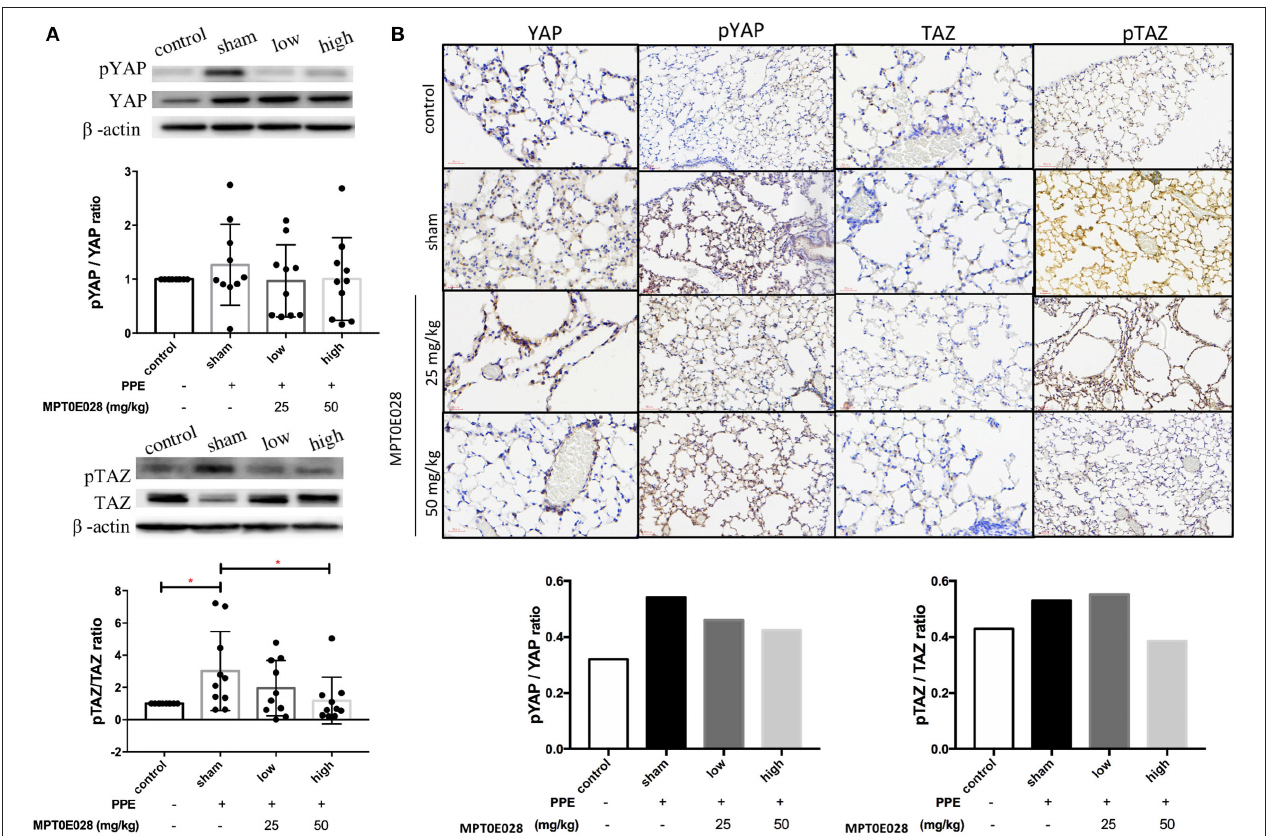
FIGURE 4 | Expressions of phosphorylated (p)-yes-associated protein (YAP) and p-transcriptional coactivator with a PDZ-binding motif (TAZ) in the lungs and alveolar regions by the MPT0E028 in mice with porcine pancreatic elastase (PPE)-induced emphysema. (A) Expressions of p-YAP/YAP and p-TAZ/TAZ in whole lung lysates by the MPT0E028 at 0, 25, and 50 mg/kg body weight (BW) ( n = 10). (B) Expressions of p-YAP/YAP and p-TAZ/TAZ in alveolar regions by IHC by the MPT0E028 at 0, 25, and 50 mg/kg BW ( n = 1) (magnification X20). * p < 0.05; ** p <